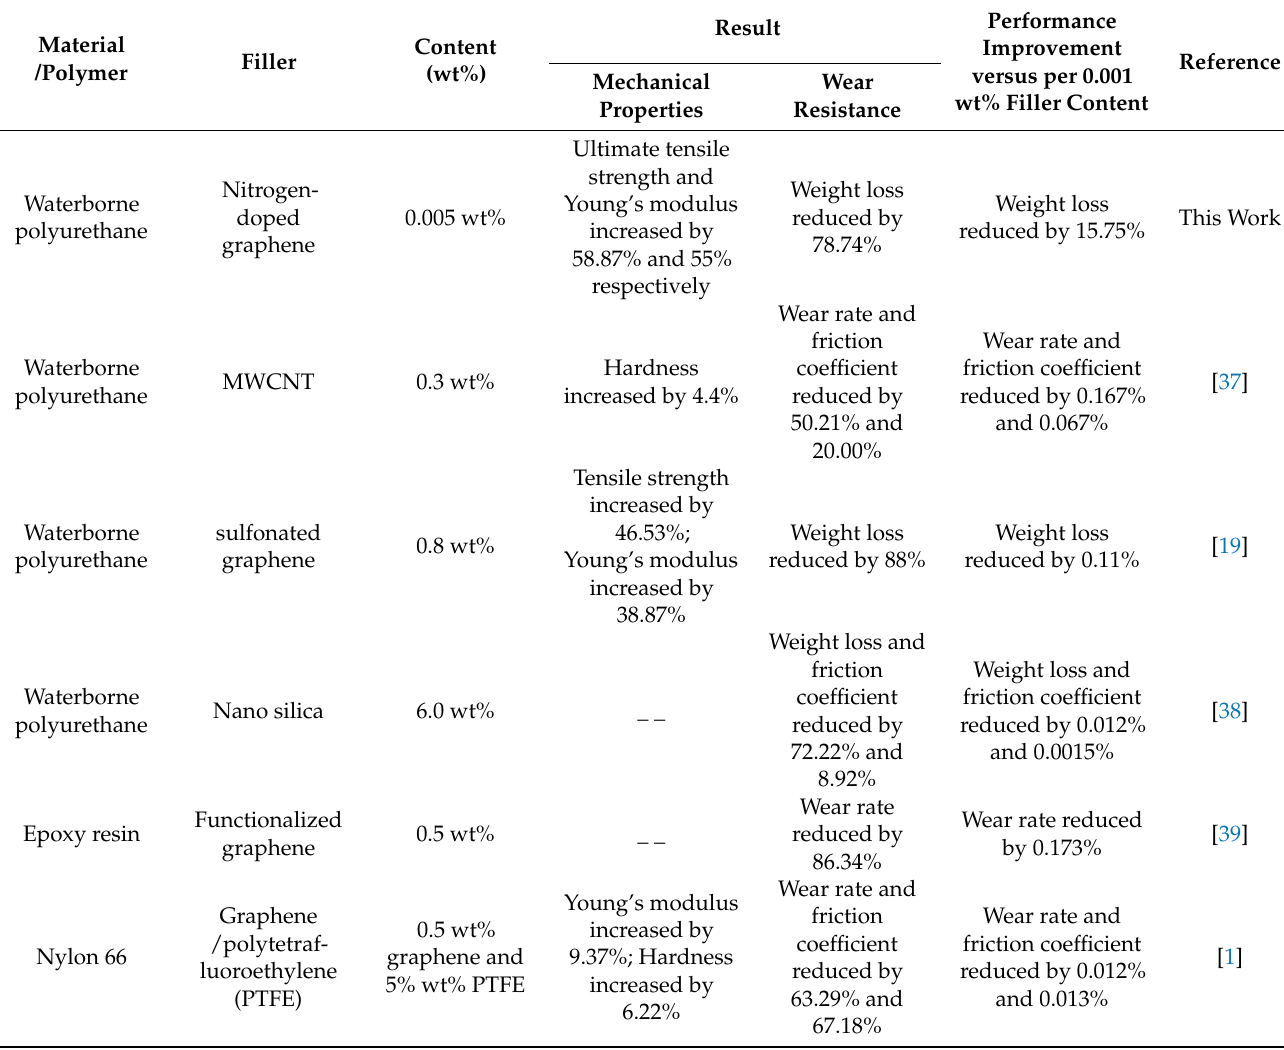
Table 3. Comparisons between this work and